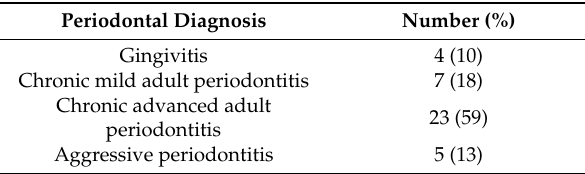
Table 2. Periodontal